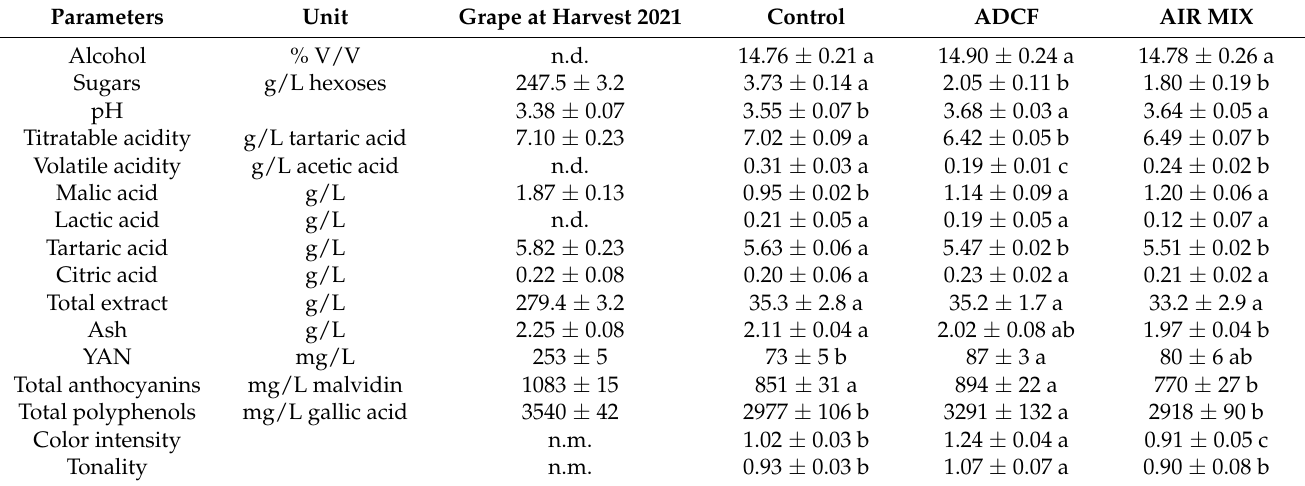
Table 2. Eno-chemical parameters of Cabernet Sauvignon grape at harvest and of the three wines for the 2021 year. Data are expressed as mean ( ± SD) of three set of berries at harvest and three 500 mL bottles, each one taken immediately after wine mixing in the tank. Different letters in a row for the wine comparison indicate statistically different data (Tukey, p ≤ 0.05). n.d., not detected; n.m., not